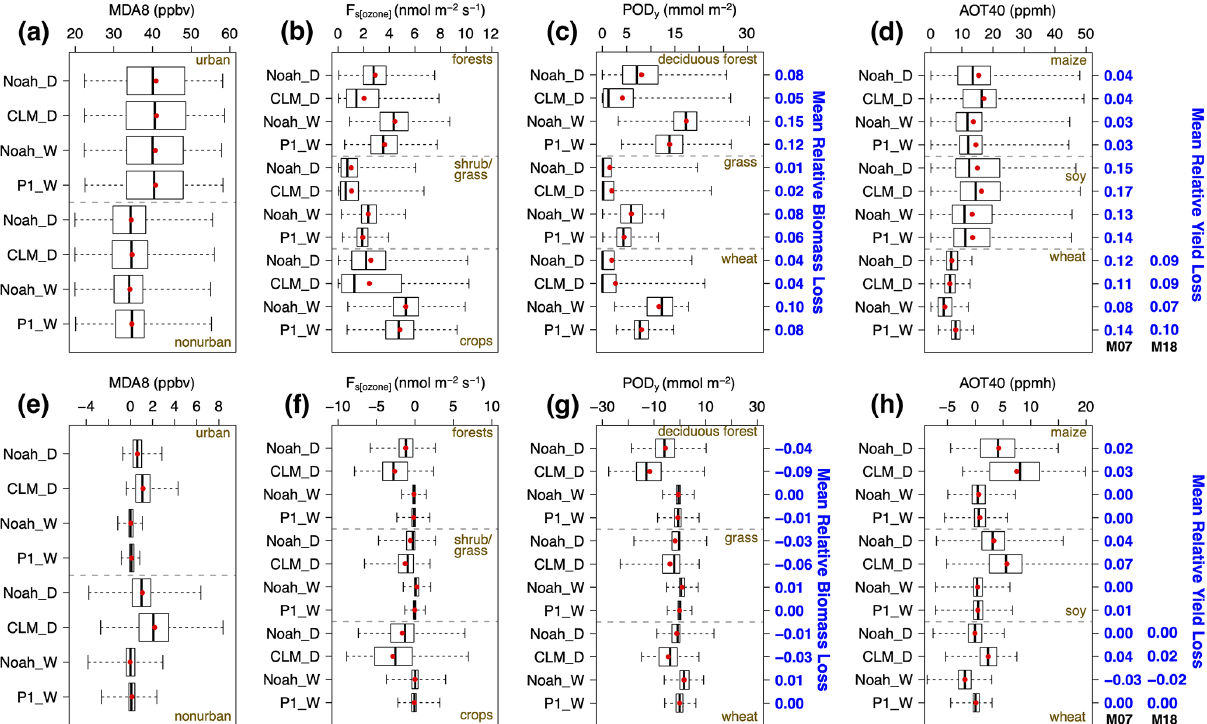
Figure 13. Box-and-whisker plots of WRF-Chem (a) MDA8 O 3 , (b) daytime stomatal O 3 uptake F s [ ozone ] , (c) derived POD y , and (d) de- rived AOT40, summarized by LULC and crop types from all DA-enabled cases. The impacts of the SMAP DA on these model fields are shown in (e) – (h) . Red filled circles indicate the mean values. The mean relative biomass/crop yield losses estimated based on all DA-enabled cases, as well as the SMAP DA impacts on these values, are included in (c) , (d) , (g) , and (h) in blue text. The crop yield losses for wheat, estimated based on the derived AOT40 and two dose–response functions (M07: Mills et al., 2007; M18: Mills et al., 2018b), are included in (d) and (h) .